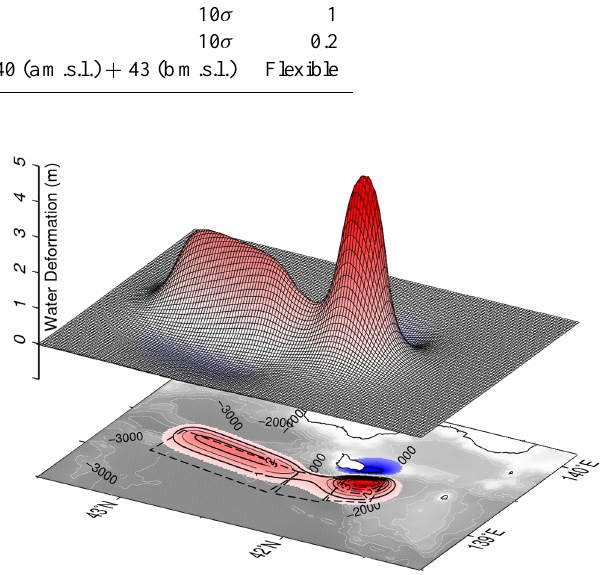
Figure 4. The total vertical component of water deformation com- puted using the Okada fault model (1985). The water deformation is computed by use of the three sub-fault parameters (DCRC-17a) summarized in Table